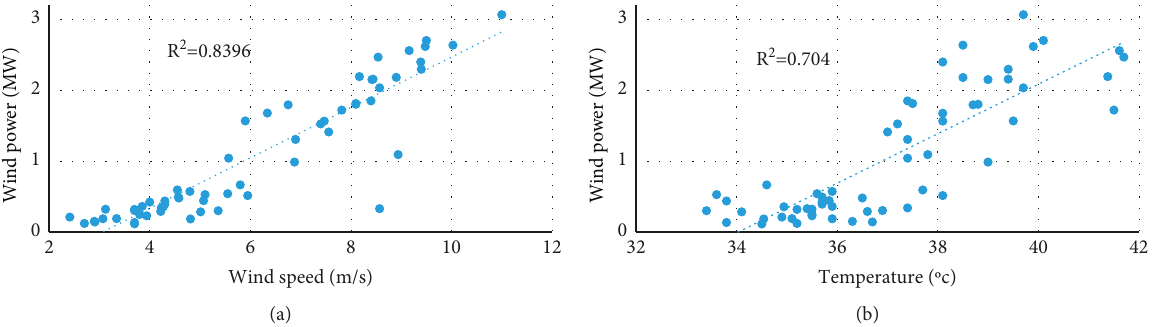
Figure 9: Relationship between independent and dependent variables. (a) For wind power vs wind speed and (b) for wind power vs temperature. Table 4: CV performance of the model. Training